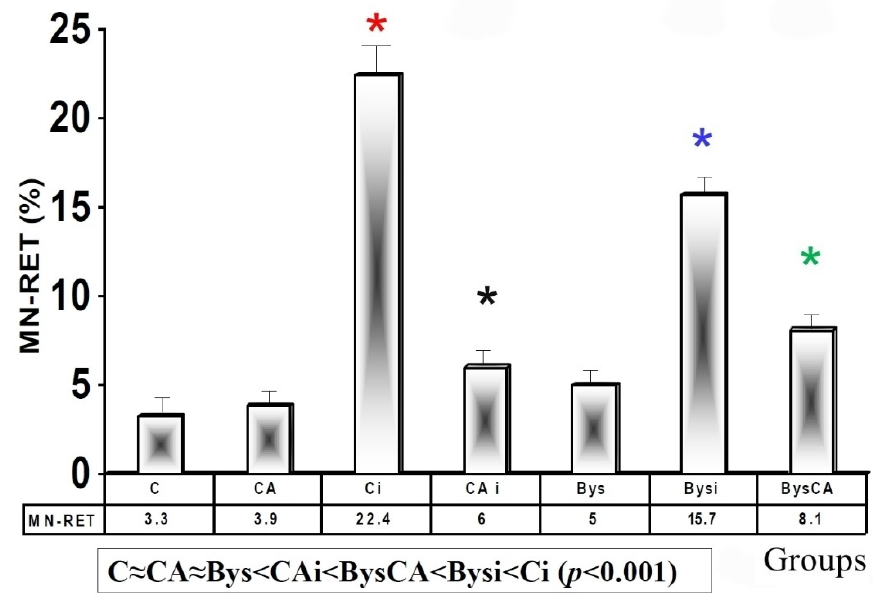
Figure 4. Frequency of reticulocytes in blood determined by flow cytometry 48h after exposure to ionizing radiation (% MN-RET) (C, control; CA, treated with carnosic acid; Ci, irradiated control; CAi, irradiated previously treated with carnosic acid; Bys, treated with serum non irradiated; Bysi, treated with serum previously irradiated; BysCA, treated with irradiated serum previously treated with carnosic acid) (* p < 0.001 versus C; * p < 0.001 versus Ci; * p < 0.01 versus Ci; * p < 0.01 versus Bysi).